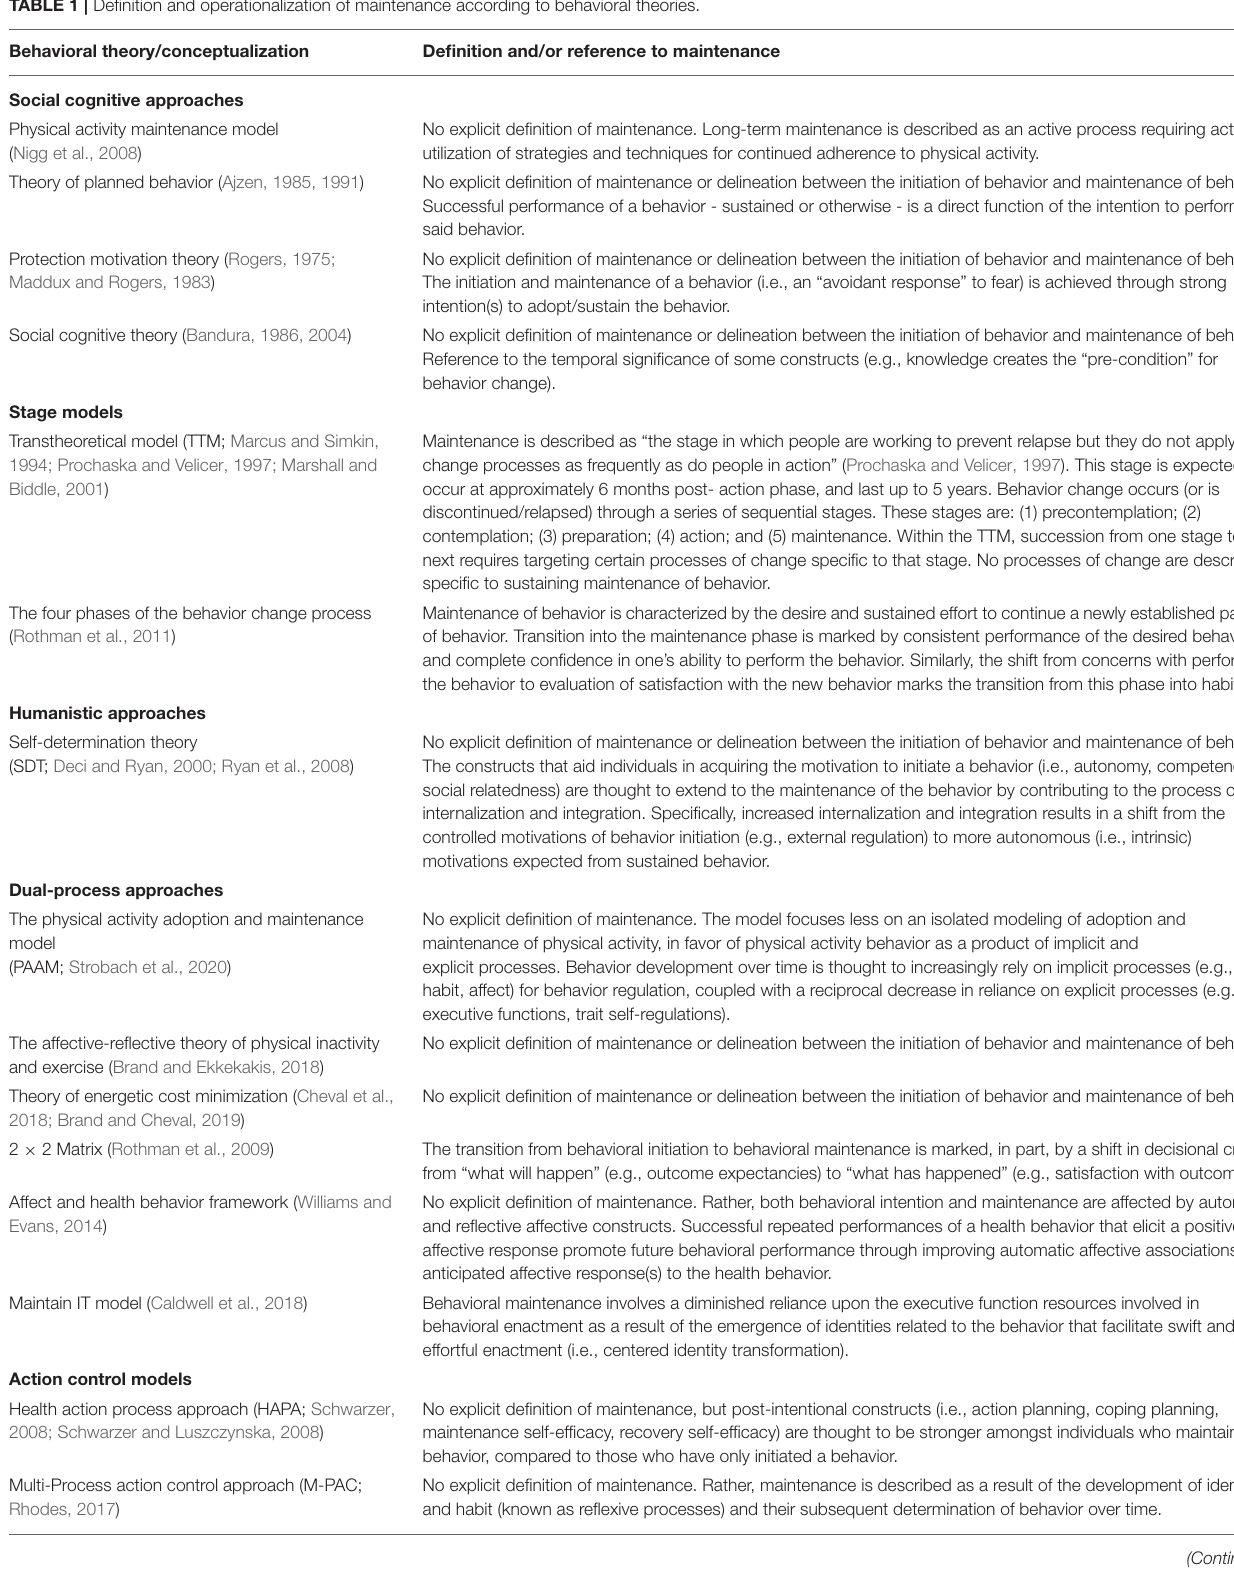
TABLE 1 | Definition and operationalization of maintenance according to behavioral